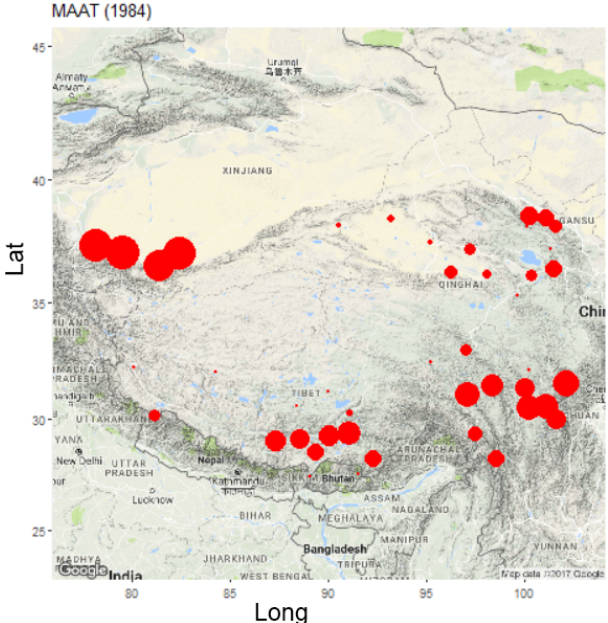
Figure 6. Index changes over time for MAAT. These graphs are animated in GIF